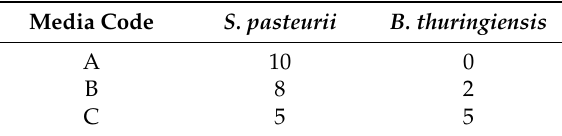
Table 1. Microbial inoculation ratio by volume